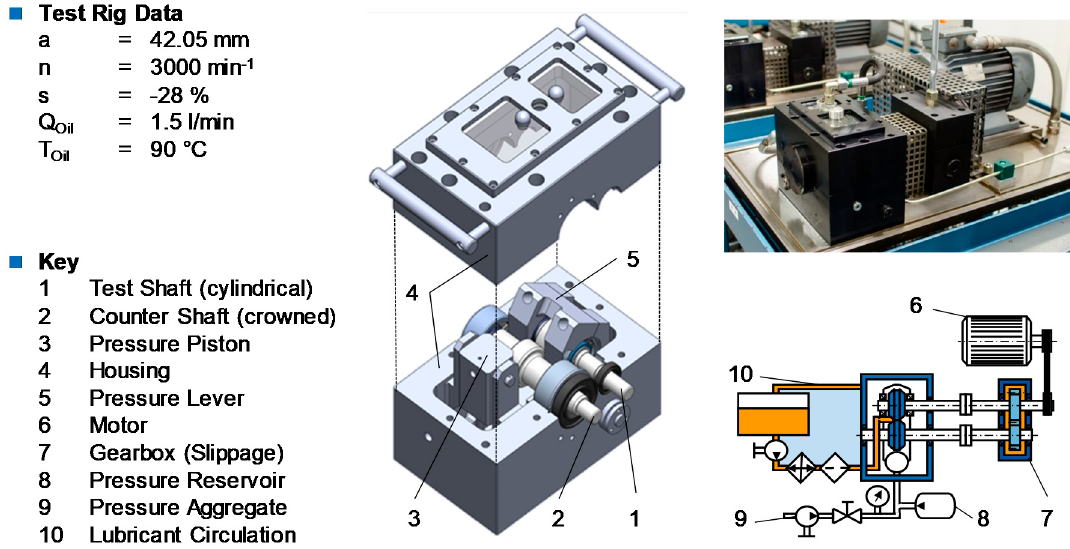
Figure 5. WZL disk-on-disk test rig for rolling-sliding contact fatigue investigations.